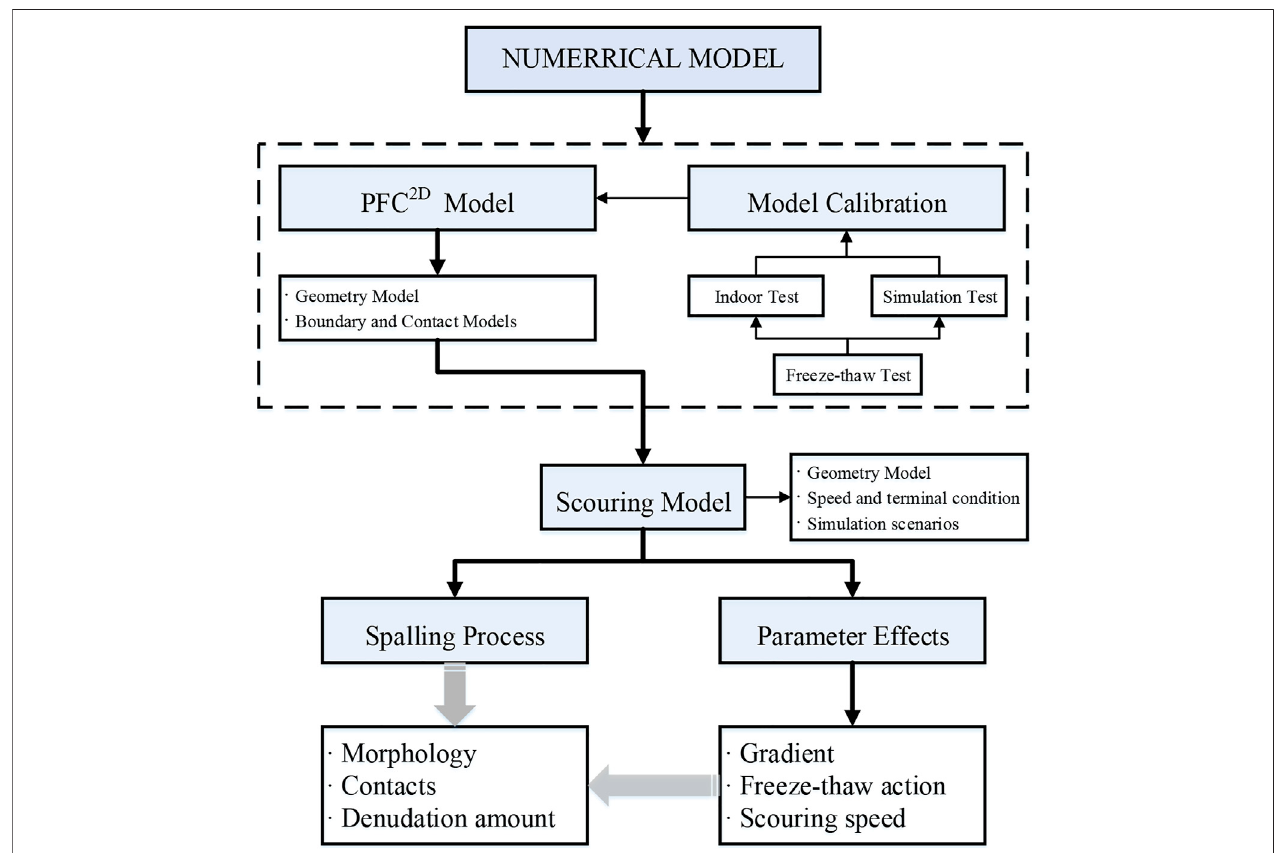
FIGURE 1 | Experimental